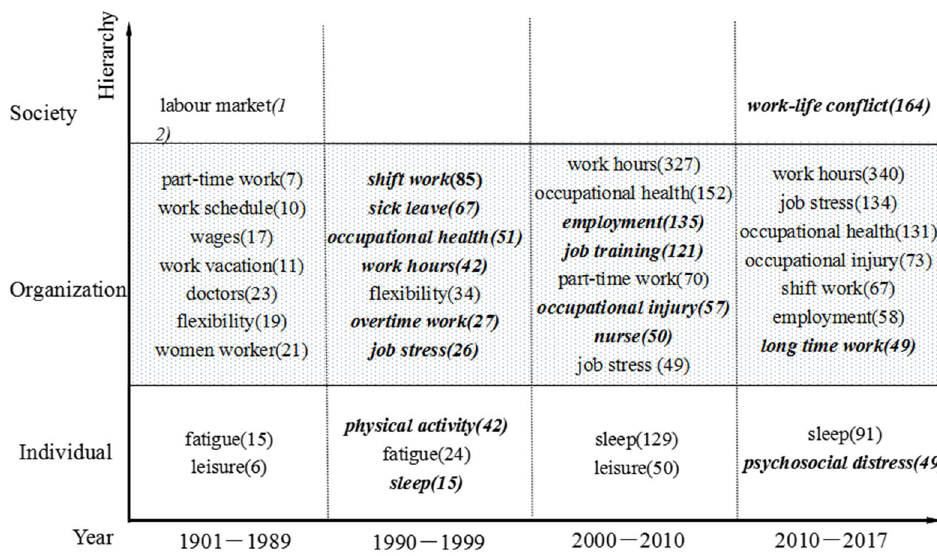
Figure 3. The specific time period of the keyword hierarchy.